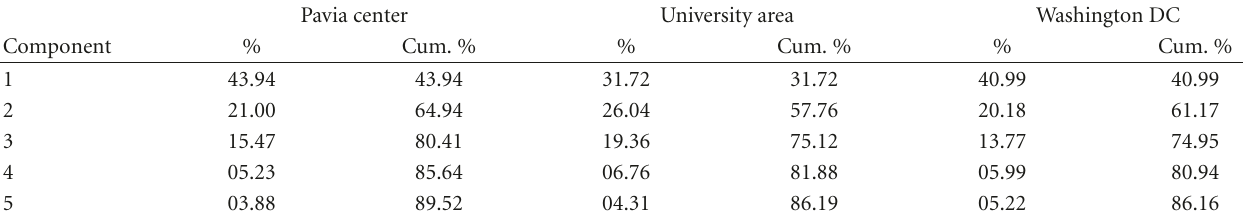
Table 5: KPCA: Eigenvalues and cumulative variance in percent for the two hyperspectral data sets (KPCA). Pavia center